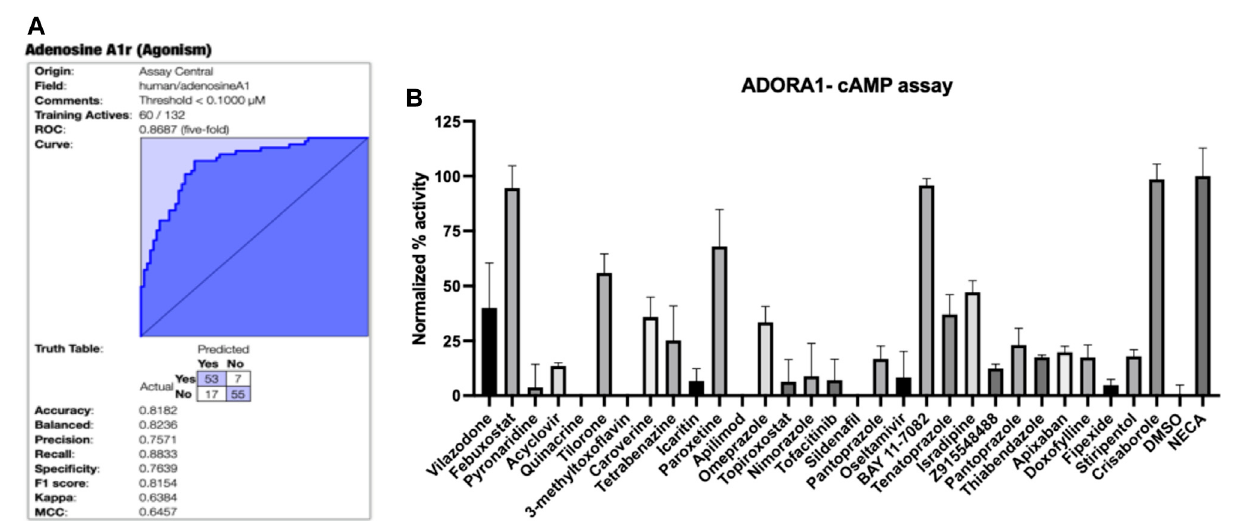
FIGURE 1 | A 1 AR machine learning model and testing of predictions. (A) Bayesian machine learning model 5-fold cross validation ROC plot showing statistics for A 1 AR (B) Normalized agonist effect of compounds in the activation of A 1 AR receptor. The cells were treated with 30 compounds at 10 µM concentration. Data points represent the mean ± SD for each condition for a single experiment performed in triplicate. The results were normalized to 10 µM NECA and vehicle (DMSO) that were considered to be 100% and 0%, respectively.